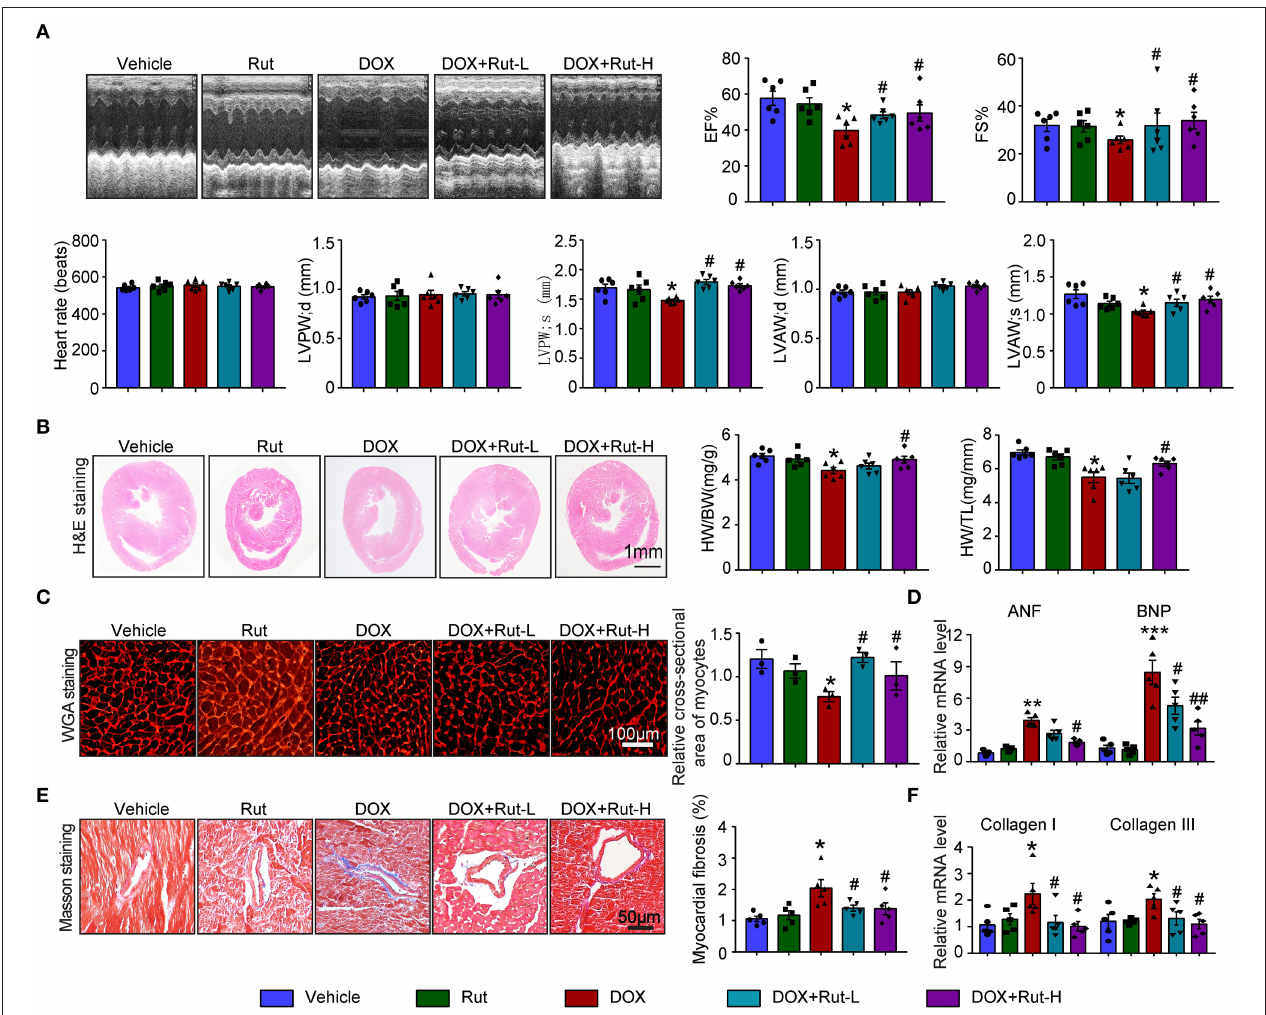
FIGURE 3 | Rutaecarpine mitigated DOX-induced cardiac dysfunction and fibrosis. Mice were treated with DOX and then on the same day received intragastric administration of 20 or 40 mg/kg Rut every day for 4 weeks. (A) Representative M-model echocardiography and the measurement of left ventricular EF% and FS%. The heart rate, LVPW, and LVAW at diastole and systole were shown below ( n = 6). (B) Representative image of HandE staining and the HW/BW and HW/TL ratios (right, n = 6). Scale bar 1mm. (C) Cardiac myocyte size was evaluated by TRITC-labeled WGA staining, and the cross-sectional area was quantified in the right panel (100 cells counted per heart, n = 3). (D) ANF and BNP mRNA expressions were determined by real-time quantitative PCR (qRT-PCR) in the heart ( n = 5). (E) Cardiac fibrosis was detected by Masson’s trichrome staining, and the relative fibrotic area was quantified ( n = 5, right). Scale bar 50 µ m. (F) The collagen I and collagen III mRNA levels in the heart ( n = 5). Data are presented as mean ± SEM, and n represents the number of animals per group. * p < 0.05, ** p < 0.01, *** p < 0.001 vs. vehicle; # p < 0.05, ## p < 0.01 vs. DOX